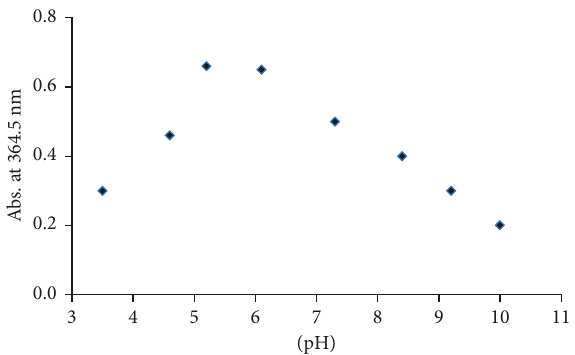
Figure 4: Effect of pH on the absorption intensity of 4 mol 1 ATN and 5 1 10 L × · mental conditions: 100 µ L SH NPs and 50mmol − −